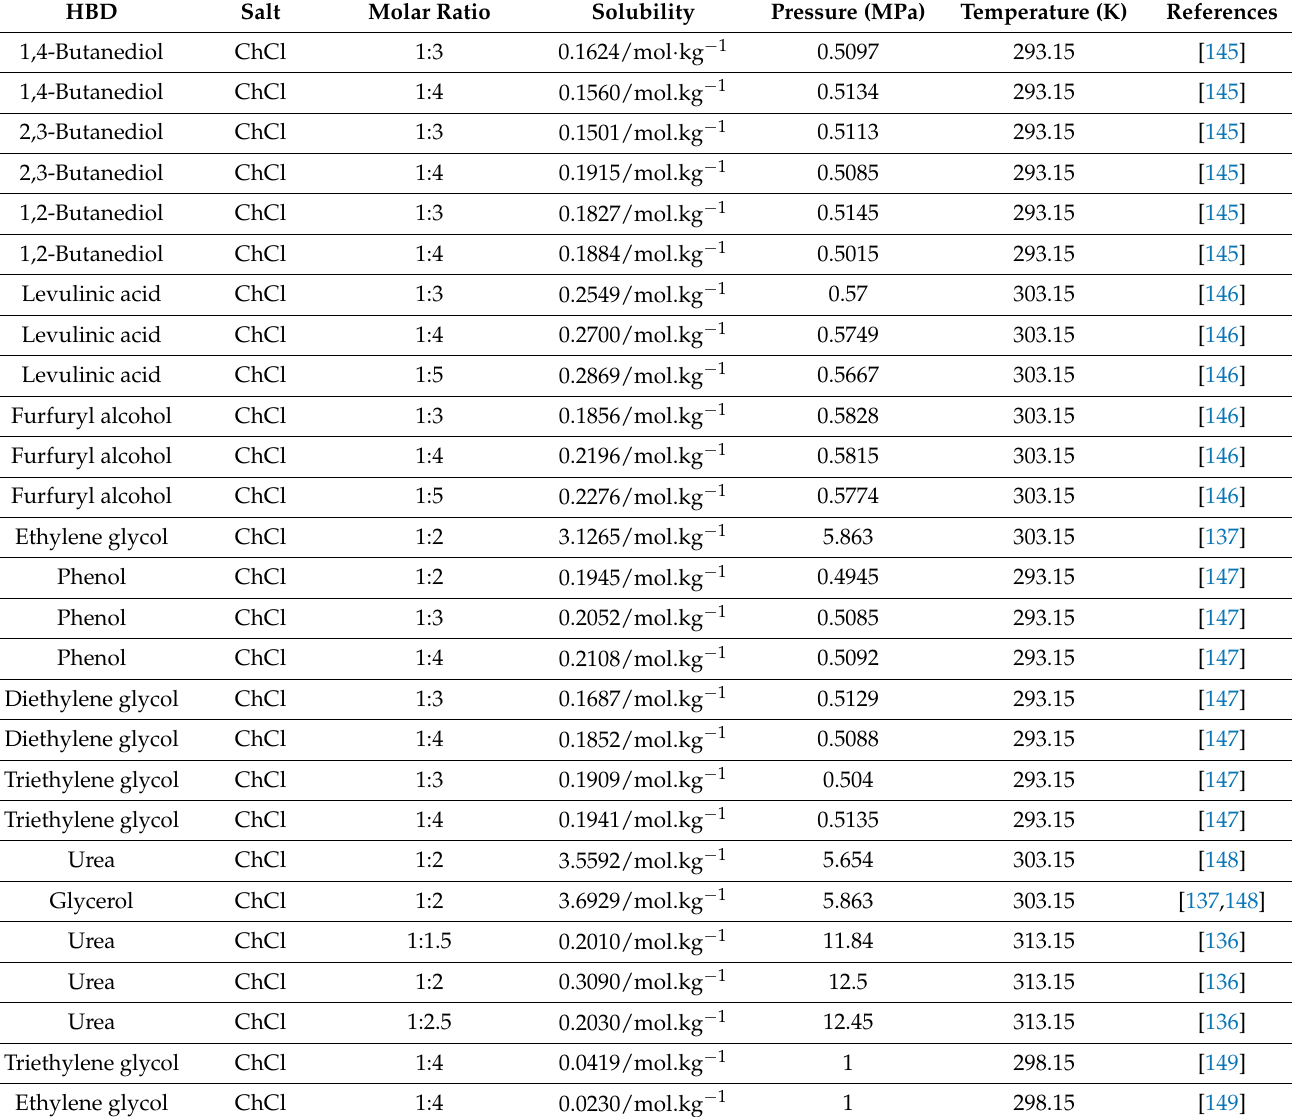
Table 5. CO 2 solubility in various